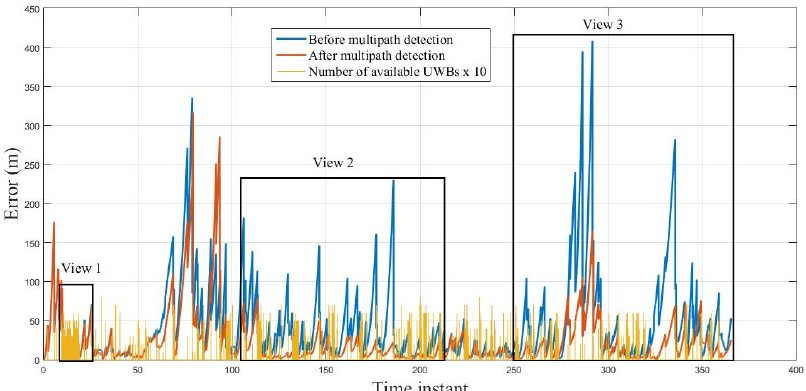
Figure 22. Localization error for UAV 103 in the developed centralized cooperative swarm. The number of UWB nodes available to UAV 103 are also shown.